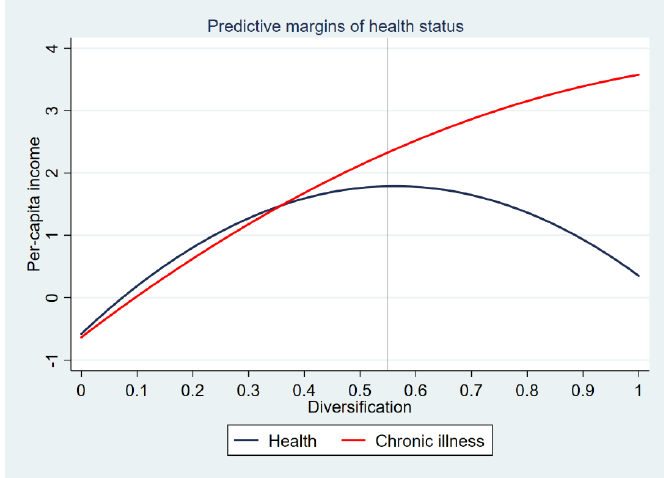
Figure 1. Income returns to diversification by health